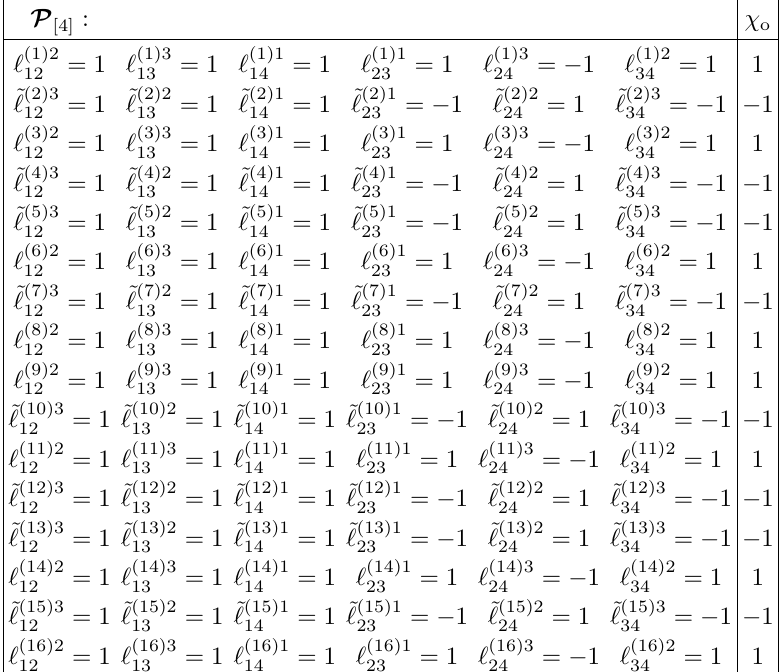
Table 14 . Non-vanishing ‘ , e ‘ , and (cid:31) o values for representation P P : [5]